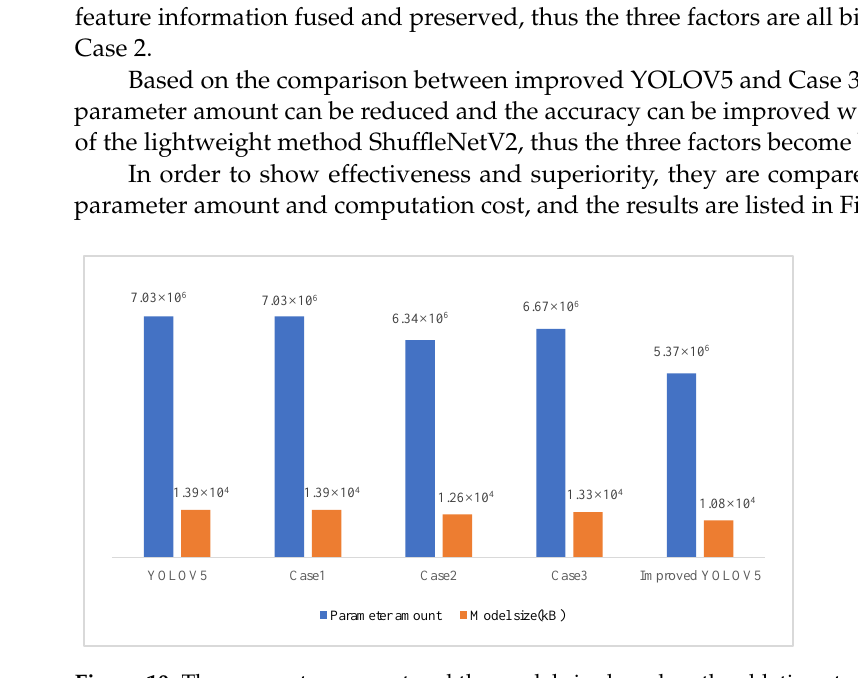
Figure 10. The parameter amount and the model size based on the ablation study.